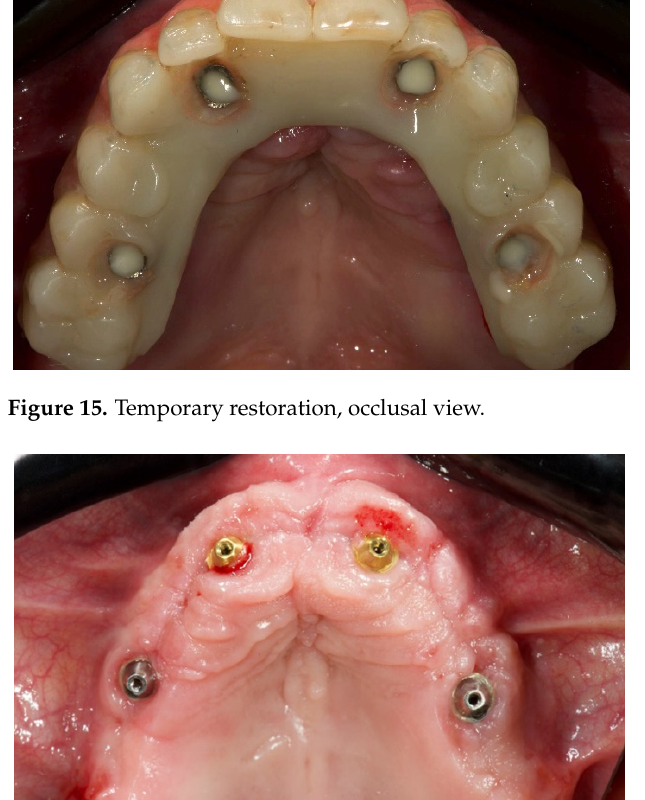
10 Figure 13. Screw-retained, temporary restoration after finishing. Figure 14. Ortopantomograph taken after implant placement.